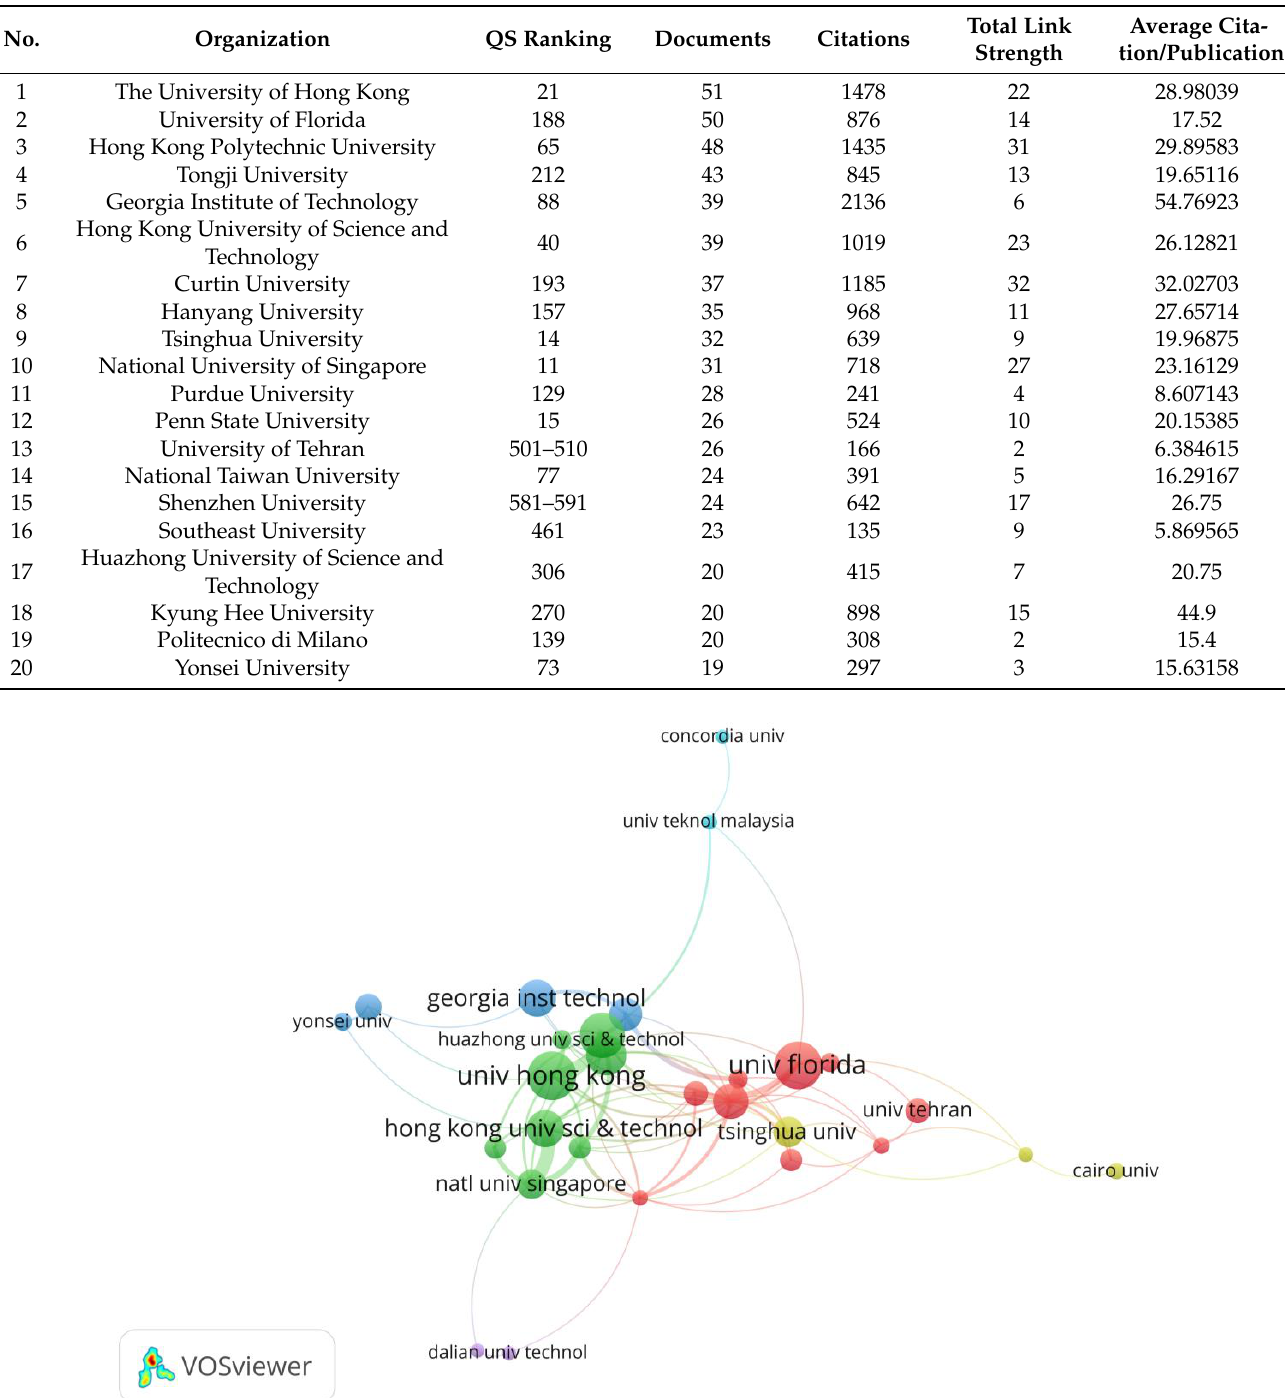
Table 2. Top 20 publishing organizations across the world.